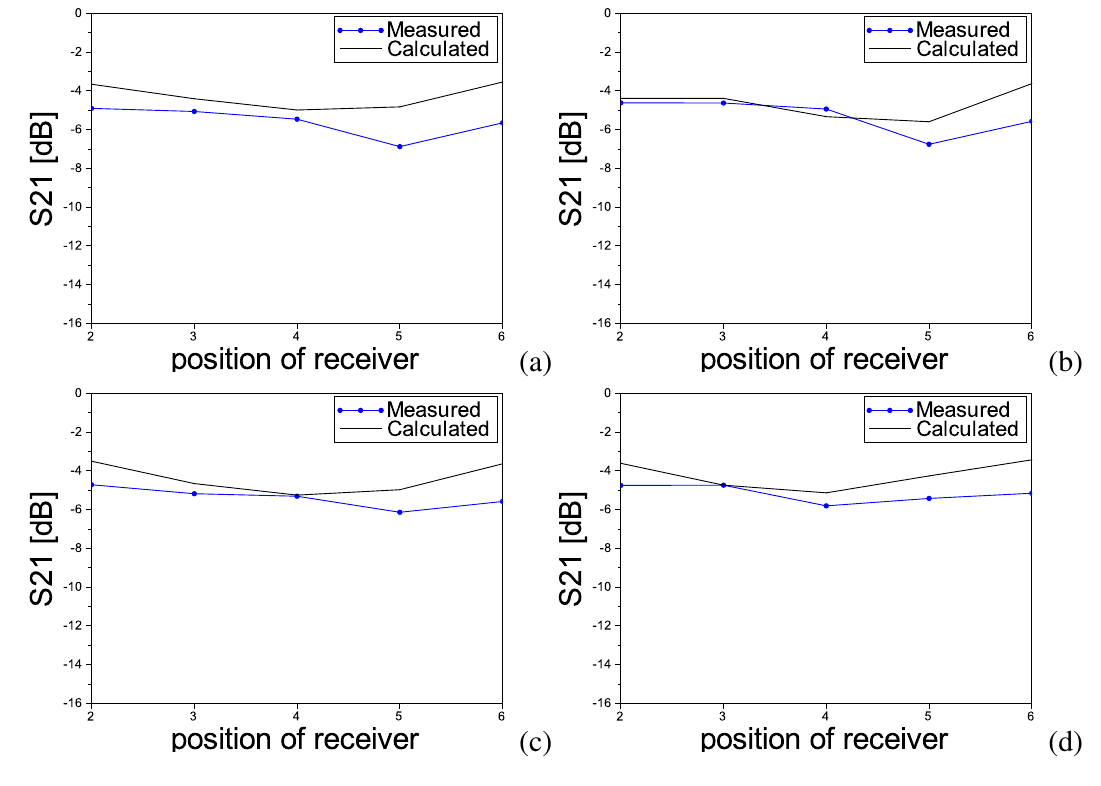
Figure 6. Measured and calculated peaks of the transmission coefficient S the position of the receiver coil for each arrangement of the array of SRs. ( a ) I-arrangement; ( b ) II-arrangement; ( c ) III-arrangement and ( d ) IV-arrangement.